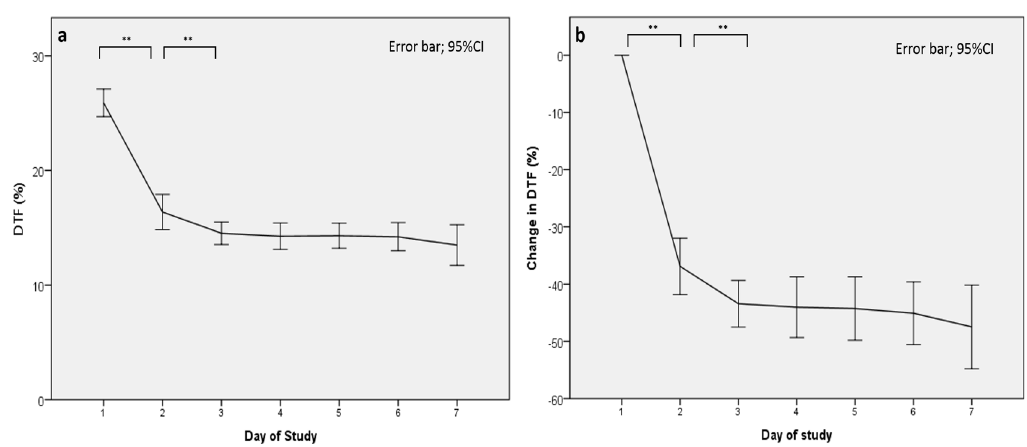
Fig 2. Averageof daily ultrasound measurements over time in the first week of MV. (a) Mean daily diaphragmatic thickening fraction (DTF), (b) change in DTF . CI = confidenceinterval; ** P < 0.005.